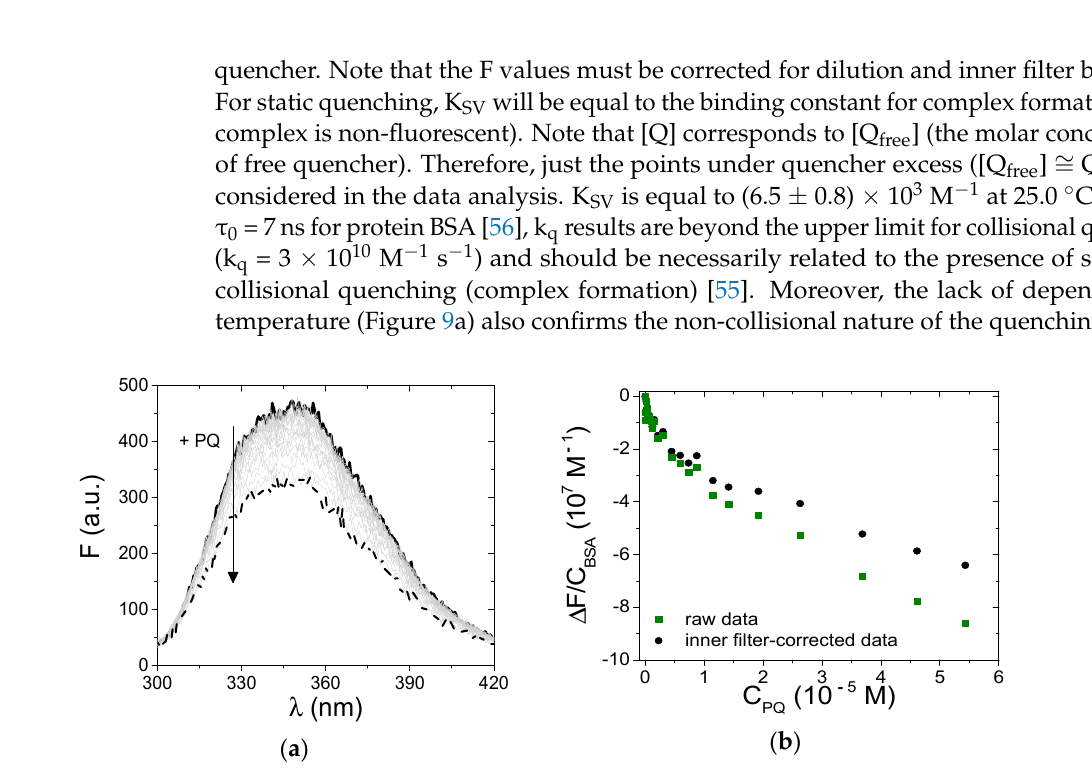
Figure 8. ( a ) Spectrophotometric titration of PQ/BSA and ( b ) corresponding binding isotherm at λ em = 345 nm; C BSA = 1.50 × 10 − 6 M, C PQ from 0 (solid) to 5.43 × 10 − 5 M (dash), NaCl 0.1 M, NaCac 2.5 mM, pH 7.0, 25.0 ◦ C, λ exc = 295 nm; squares refer to uncorrected fluorescence values, circles define the trend corrected according to the equation in the text.